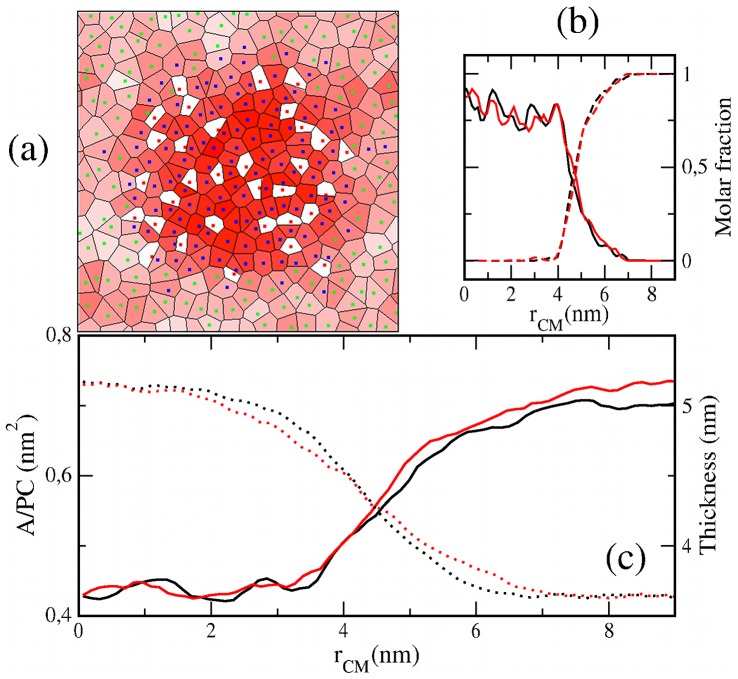
Simulation of the lo patch membrane.(a) Voronoi tessellation of the lo patch membrane at the end of the simulation. Polygons are filled with a red color scale proportional to the local membrane thickness. (b) Molar fraction of DSPC (solid) and DOPC (dashed) respect the distance to the center of mass of the nanodomain. (c) Profiles for the area per PC (solid) and thickness (dotted). An average over the last 48 ns of simulation of the chlf-free (black) and chlf-containing (red) lo patch bilayers are plotted in panels (b,c).